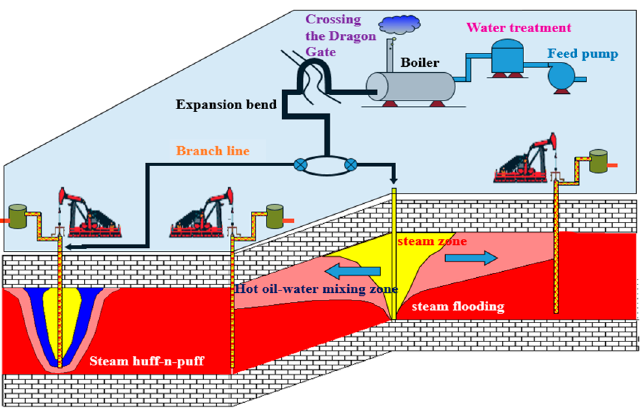
Figure 1. Steam huff and puff and steam flooding.